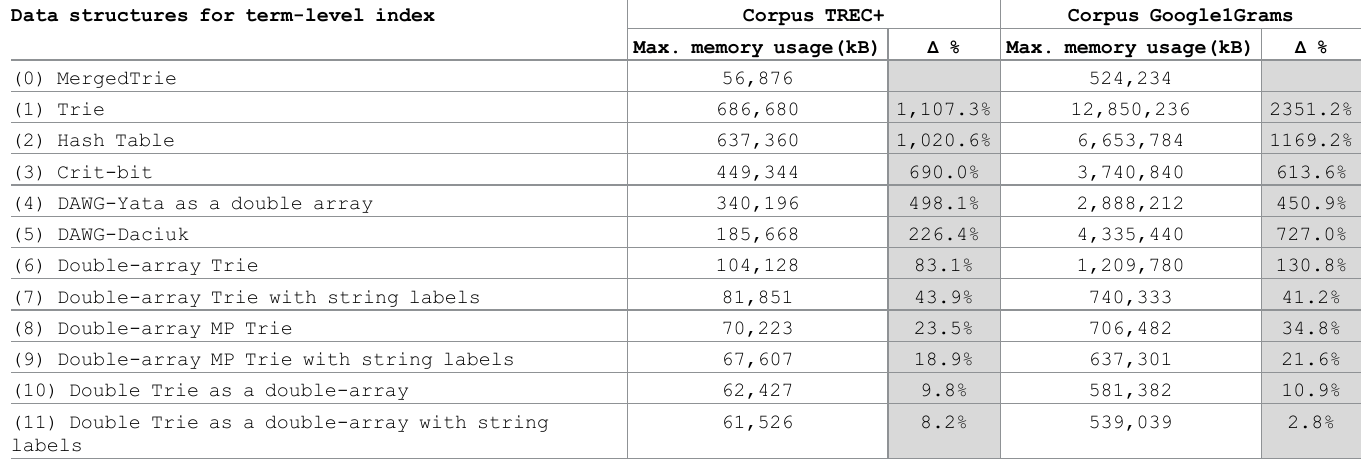
Table 2. Max. memory usage (kB) with both corpora: TREC+ (7,184,348 words) and Google1Grams (58,654,411 words). Data structures for term-level index Corpus TREC+ Corpus